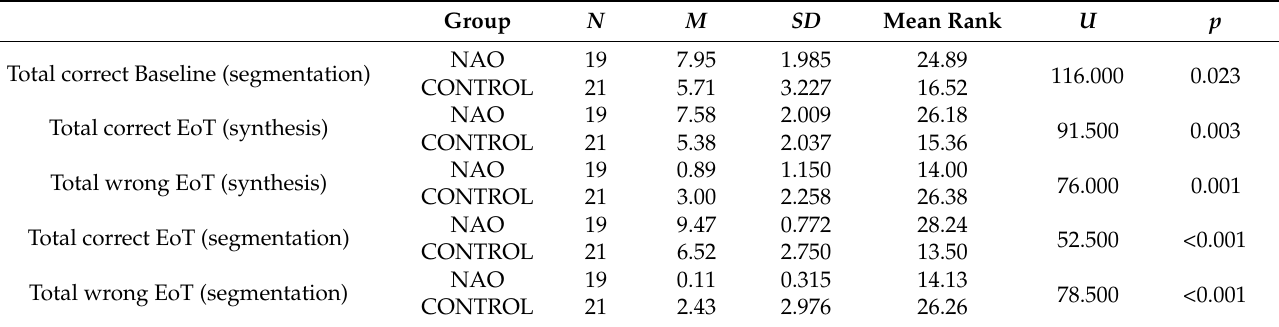
Table 2. Significant changes by group between the beginning (baseline) and the end of treatment (EoT) in the phonological awareness evaluation scores.